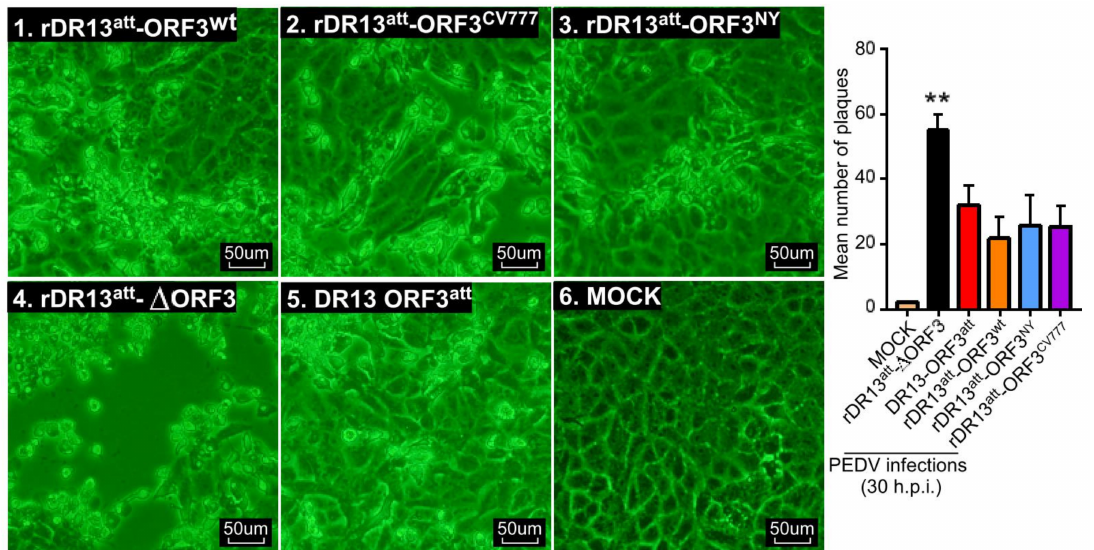
Figure 5. Comparison of cytopathic e ff ect (CPE) caused by di ff erent viruses. Vero cells were mock-infected or infected with rDR13 att -ORF3 wt , rDR13 att -ORF3 CV777 , rDR13 att -ORF3 NY , rDR13 att - ∆ ORF3, and DR13 att at a MOI of 0.1. CPE was monitored and photographed at 30 h.p.i. using an inverted microscope at a magnification of 200 × . Results shown in the histogram (right panel) represent the mean ± SD from three parallel tests. Symbol ** indicates that the di ff erence of extent of CPE caused between rDR13 att - ∆ ORF3 and the other viruses is very significant ( p < 0.01). Scale bar represents 50 µ m.